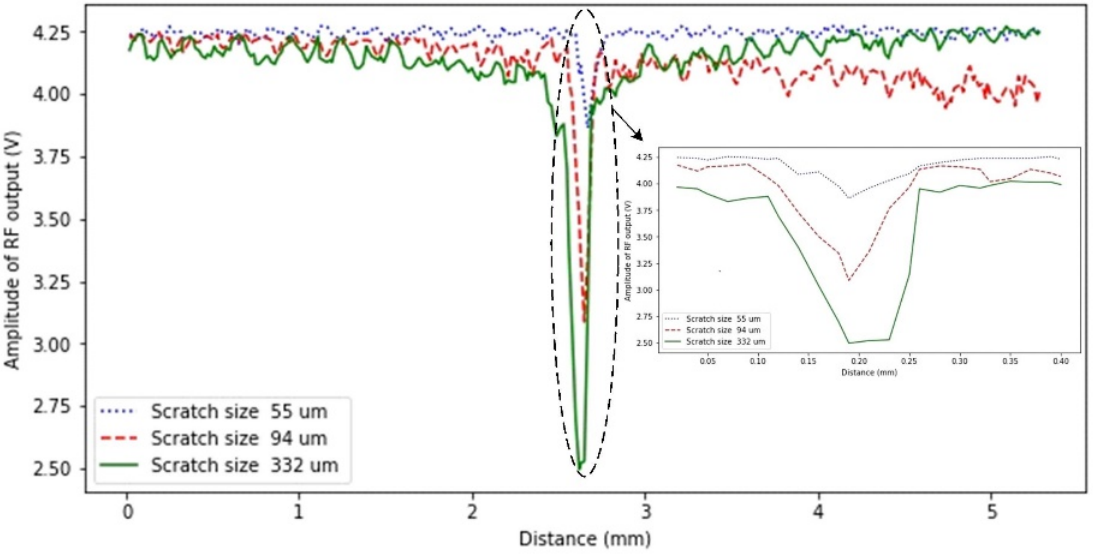
Figure 7. Distance and amplitude measurements of 3 scratches detected by the CD pick-up head.